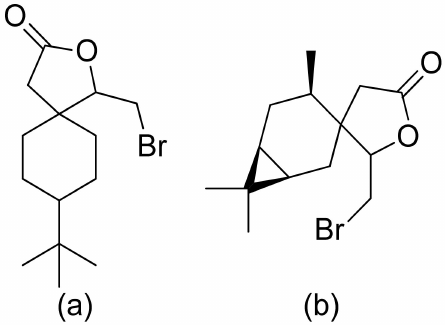
Figure 4. Bromolactone derivatives of monoterpenoids ( a , b ). Mazur and colleagues synthesized anisaldehyde lactone derivatives and evaluated their antibacterial activity. One of the tested compounds (Figure 5) presented significant activity against two strains tested: S. aureus and Listeria monocytogenes . The MIC80 values were 50 and 100 ; µ g/mL, respectively